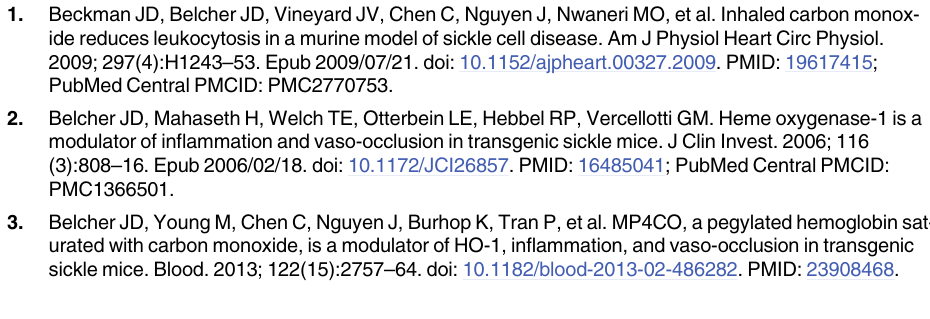
S4 Fig. NF- κ B total p65 immunoblot uncropped. Townes-SS mice (n = 3/group) were gavaged once-daily with HBI-002 or vehicle (10 ml/kg). On day 10 of treatment the livers were removed and frozen. NF- κ B total p65 expression was examined on an immunoblot of hepatic nuclear extracts. S5 Fig. VCAM-1 immunoblot uncropped. Townes-SS mice (n = 3/group) were gavaged once-daily with HBI-002 or vehicle (10 ml/kg). On day 10 of treatment the livers were removed and frozen. VCAM-1 expression was examined on an immunoblot of hepatic micro-